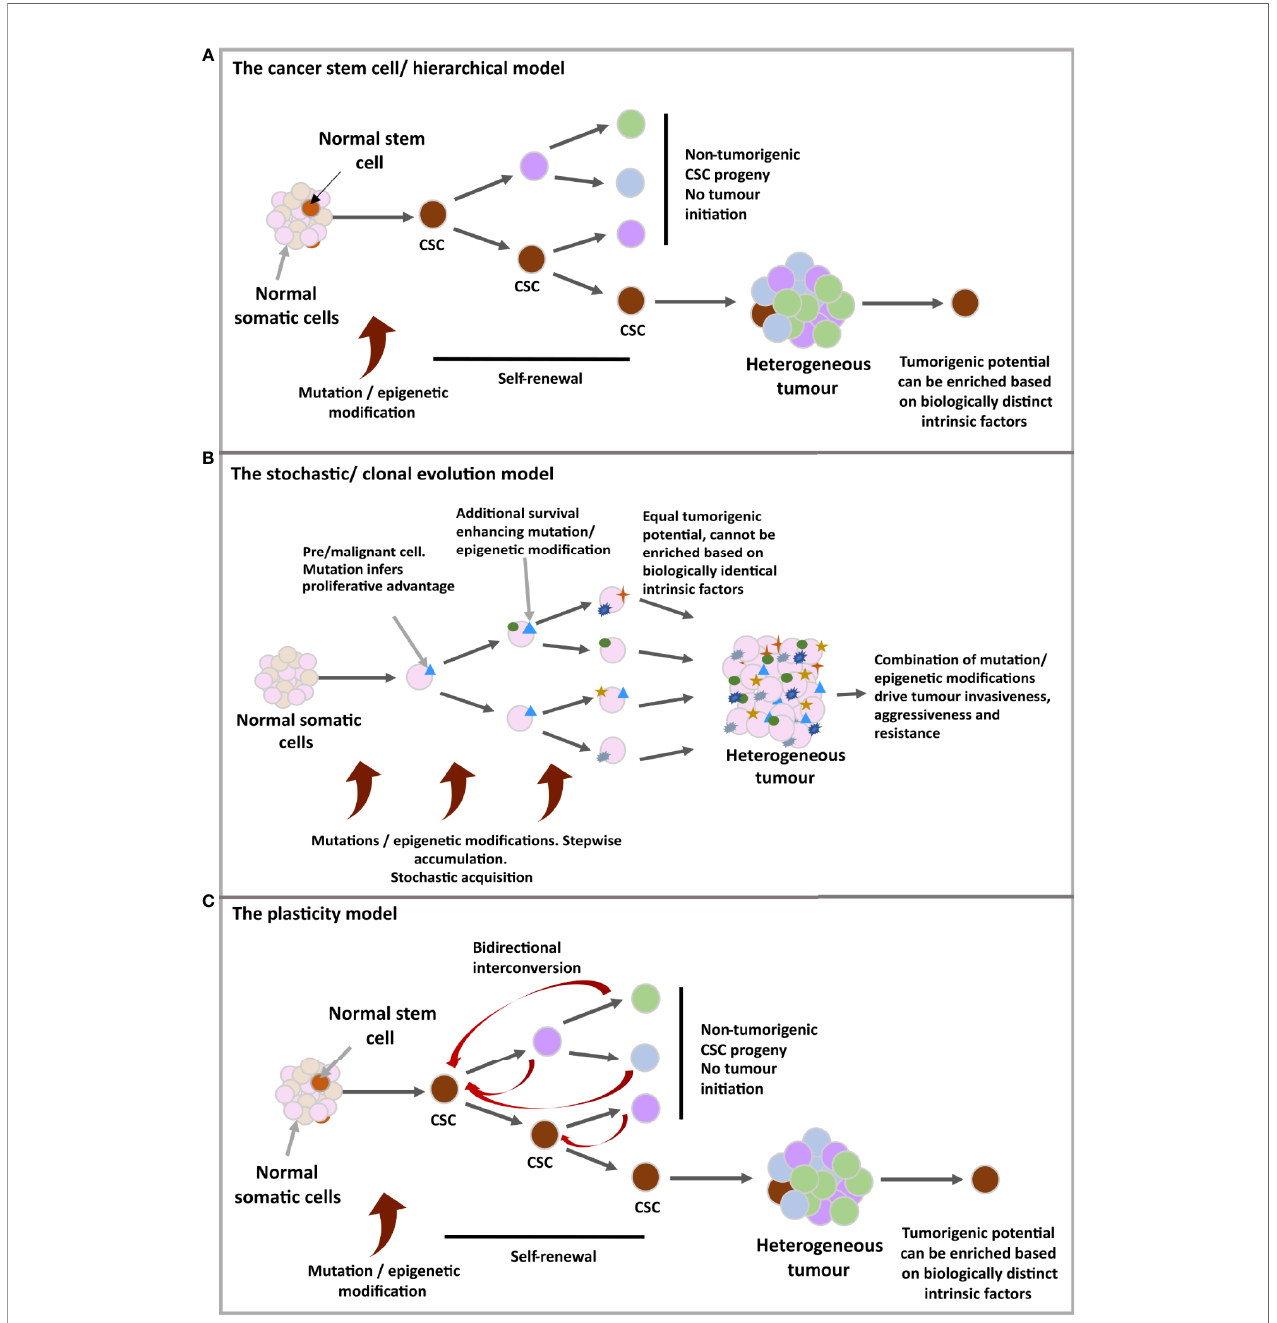
FIGURE 1 | (A) The cancer stem cell/hierarchical model: The CSC bene fi ts from inherent stem cell features to support malignancy; unlimited clonal expansion and self-renewal. The self-maintaining CSC population(s) are believed to differentiate in a reversible manner, producing different tumoral populations of faster proliferating cells with limited lifespan. A hierarchy is set up in which CSCs de fi ne a biologically distinct subdivision of a tumour, giving rise to further behaviourally and functionally heterogenous, non-tumorigenic cells of the tumour bulk. (B) The stochastic/clonal evolution model: Following neoplastic induction via oncogenic mutation, rapid proliferation, in combination with cumulative mutation acquisition would give rise to variants with additional selective advantages. In this model, any malignant cell is assumed as having an equal probability for tumour initiation due to identical biological features and the stochastic nature of mutation acquisition, as well as the unpredictable in fl uence of external cues on behavioural shifts. Therefore, tumour initiating ability cannot be isolated or enriched for. (C) The plasticity model: A more fl exible model, ‘ merging ’ the two previous models. Possible incorporation for bidirectional interconversion between cellular potencies, including the retrodifferentiation of non-cancer stem cells to reacquire stem